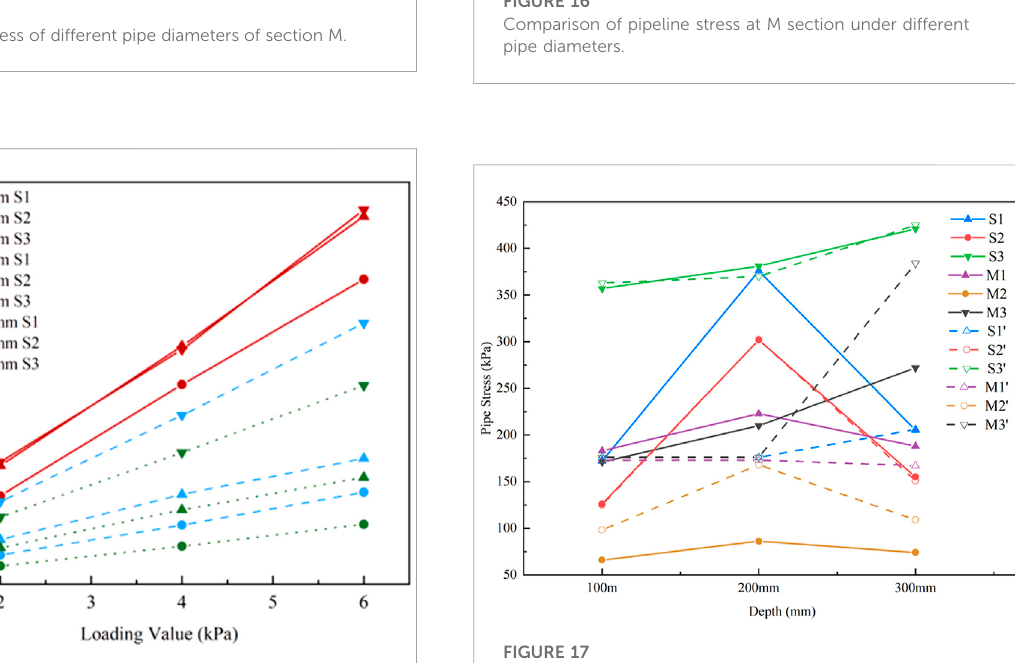
FIGURE 15 Pipeline axial stress of different pipe diameters of section S.